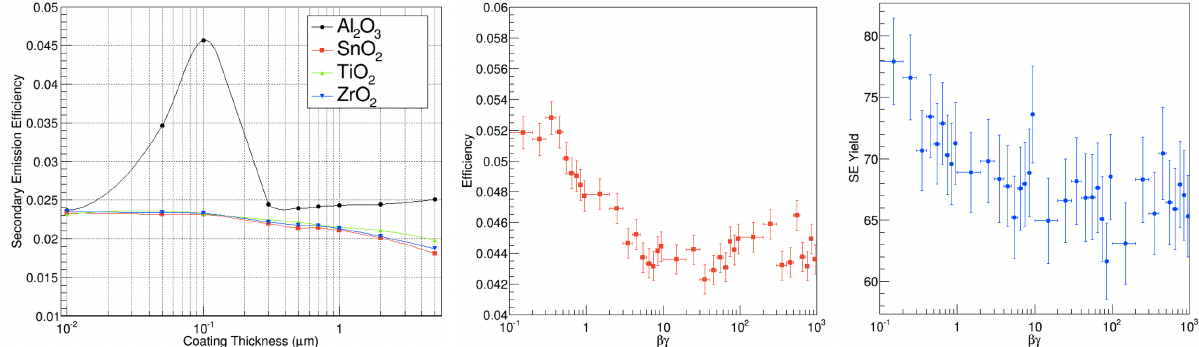
Figure 4. The simulated efficiencies for different thicknesses of Al 2 O 3 , SnO 2 , TiO 2 and ZrO 2 ( left ), the secondary electron emission efficiency ( center ) and the SE yield ( right ) of the cathode once efficient as a function of the βγ of the traversing particle for a 100-nm Al 2 O 3 -coated copper